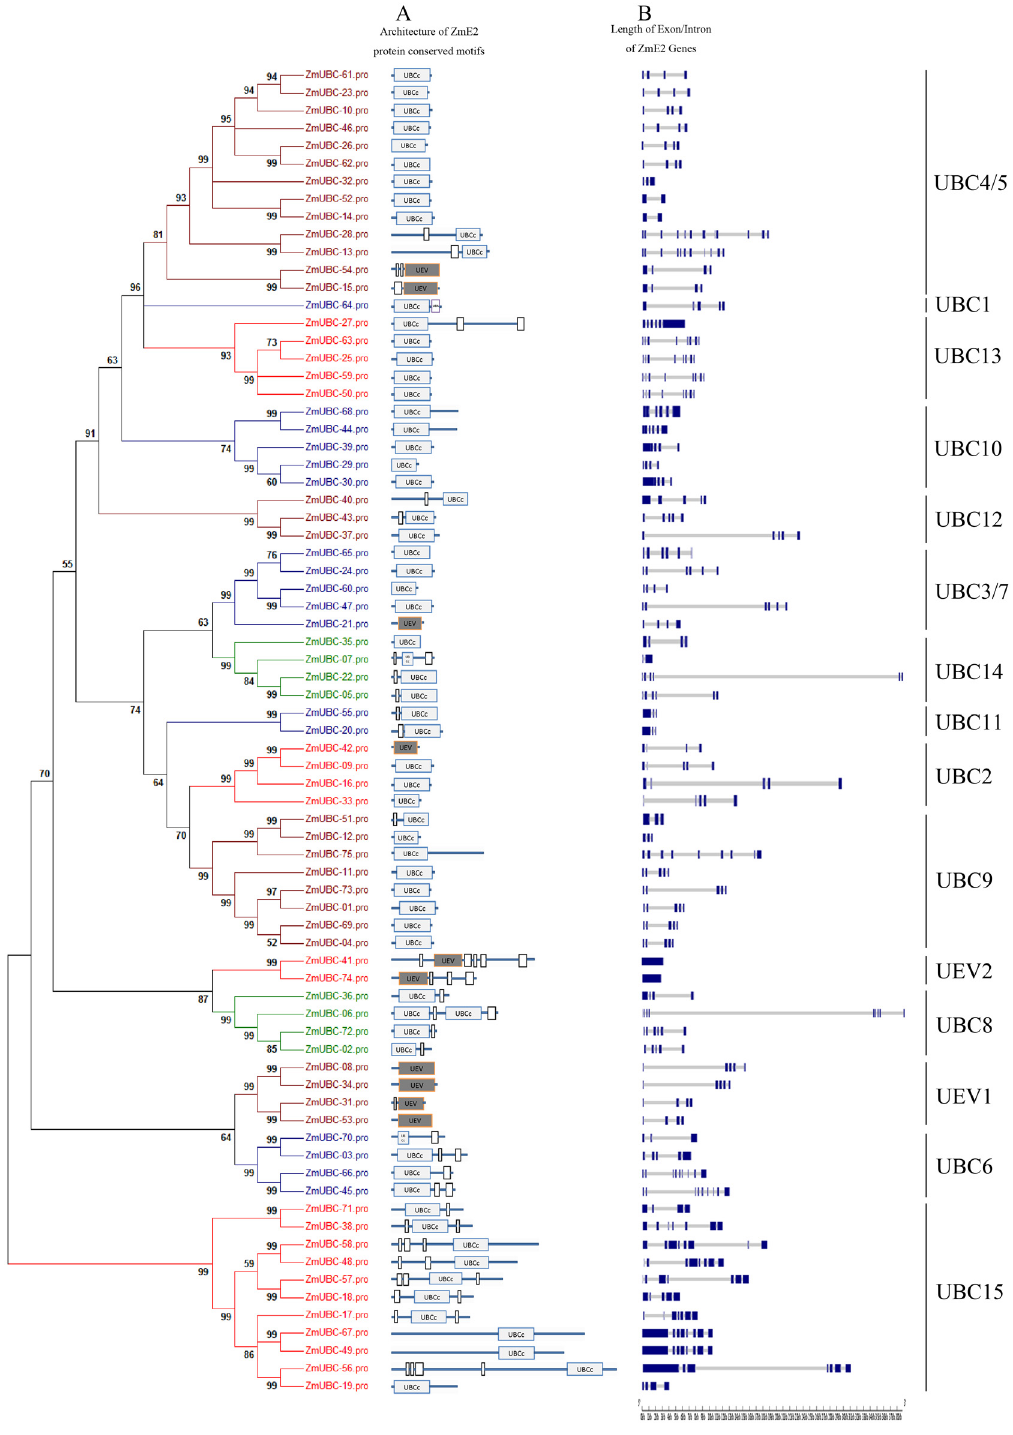
Fig 3. The architecture of conserved protein motifs and intron pattern of ZmE2s. (A) Architecture of conserved protein motifs of UBC proteins. (B) The gene structure is presented by blue exon(s) and spaces between the blue box corresponding to intron (s). The sizes of the exons and intron can be estimated using the horizontal